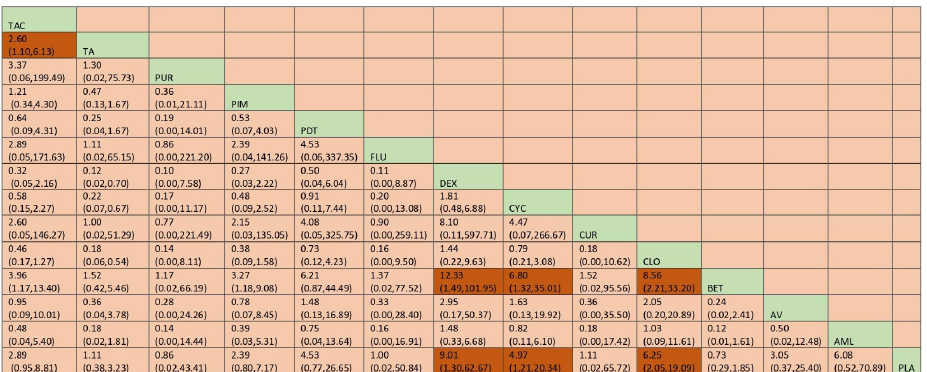
Figure 17. League table for adverse effects (subgroup analysis). Abbreviations: AML, amlexanox paste; AV, aloe vera; CUR, curcumin gel; PDT, photodynamic therapy; PLA, placebo; PUR, purslane; TAC, tacrolimus; FLU, flucinonide acetonide; CLO, clobetasol propionate; PIM, pimecrolimus; BET, betamethasone; TA, triamcinolone acetonide; DEX, dexamethasone; CYC, cyclosporine. The green highlights indicate the interventions and the dark highlights indicate the significant results.